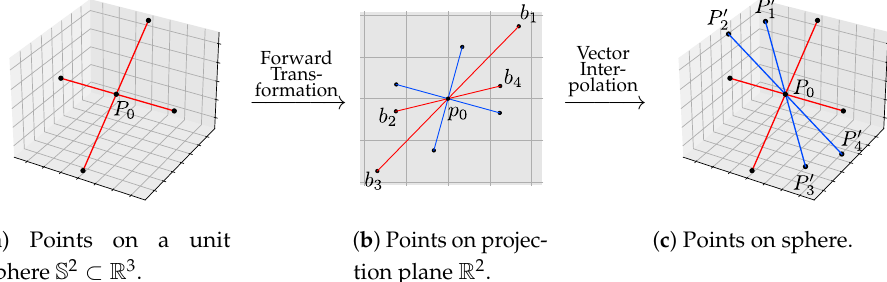
Figure 3. Schematic diagram of sampling and interpolation for the proposed FWD–GCA-based